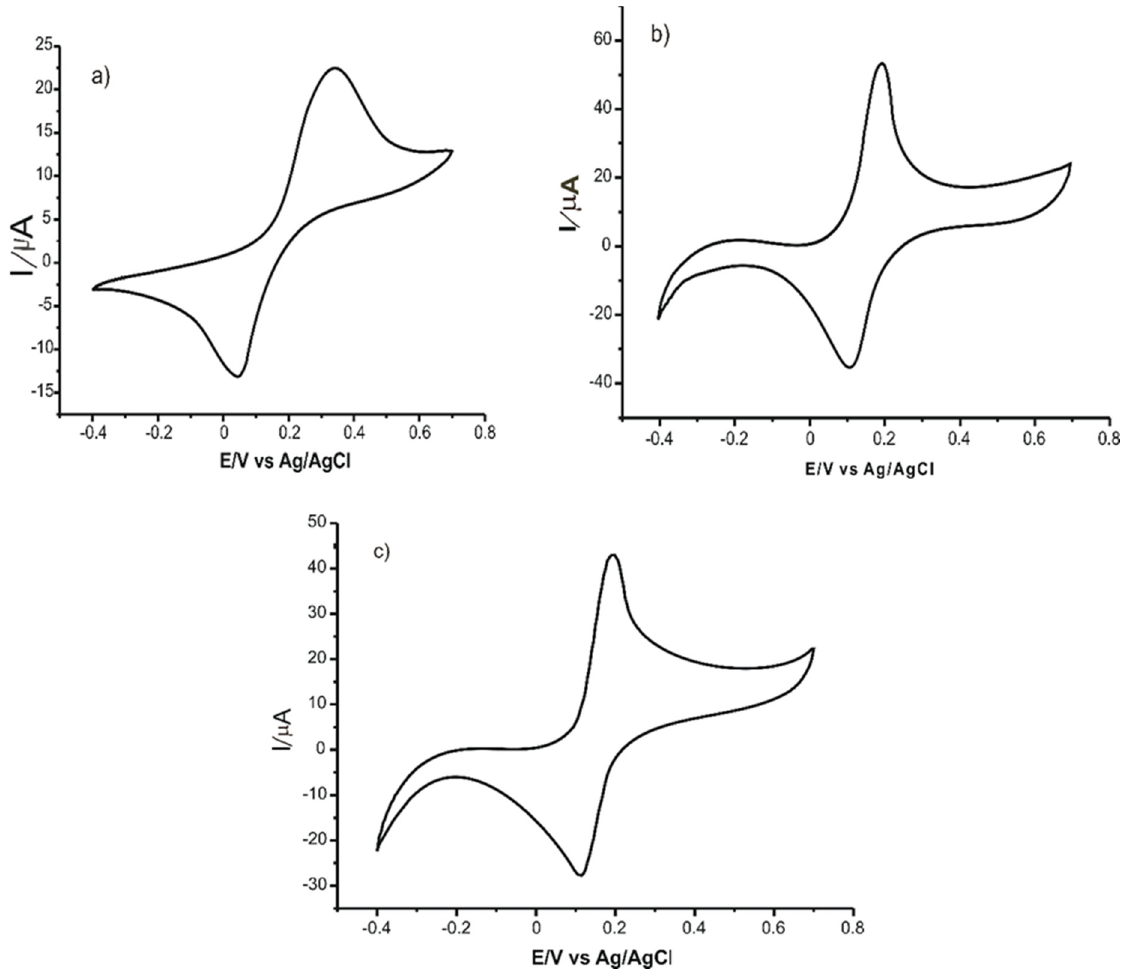
Figure 11. CVs of: ( a ) C-SPEs, ( b ) GPH-SPE and ( c ) GPH-GNP-SPE immersed in 10 − 3 M CGA solution (support electrolyte 10 − 1 M PBS solution). Scan rate 0.1 V·s − 1 [58].